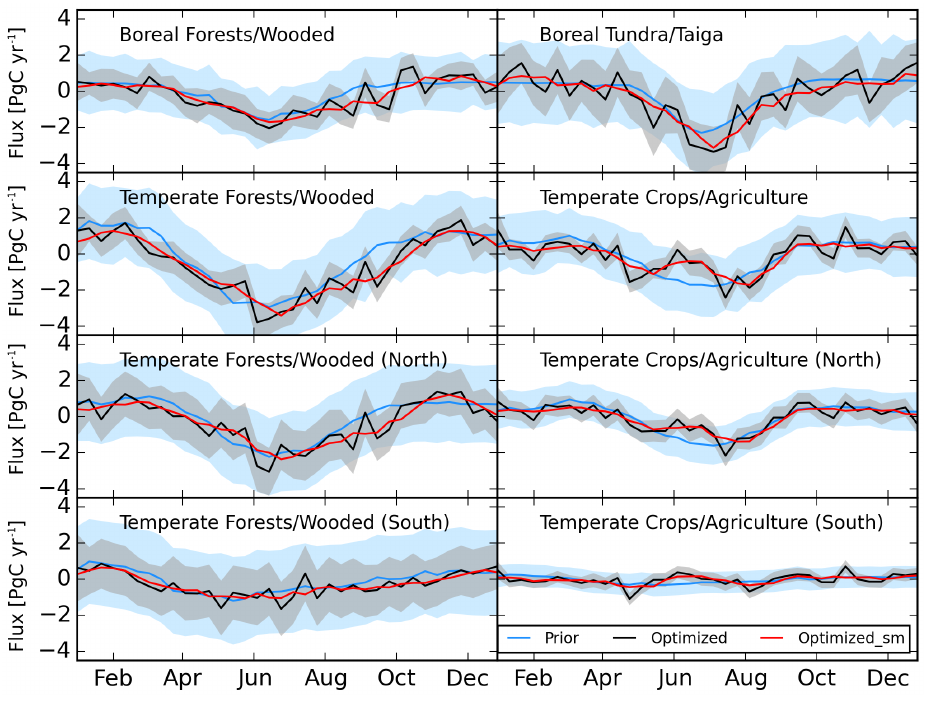
Figure 4. The seasonal cycle (10-day resolution) of the net CO 2 biosphere flux (PgCyr − 1 ) of four aggregated Olson ecoregions in North America for the year 2010. The prior biosphere flux (SiBCASA) and its uncertainty are displayed in blue, and the optimized biosphere flux and uncertainty in black. “Optimized_sm” stands for the smoothed optimized fluxes (shown in red), which helps to remove the spurious fluctuations. The Temperate Forests/Wooded and Crops/Agriculture are separated by 40 ◦ N into North and South, respectively.